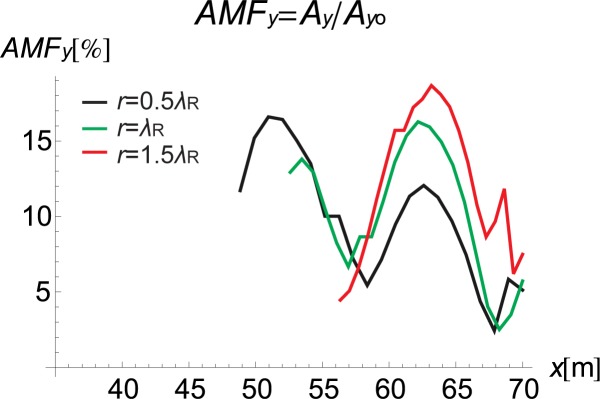
AMF for the Vertical Displacement α = 30°: Red–r = 1.5λR, Green–r = λR, and Black–r = 0.5λR.